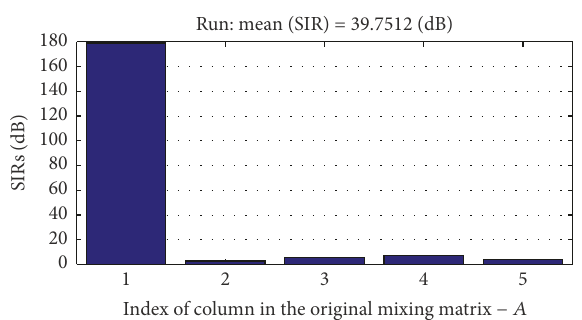
Figure 7: Signal to interference ratio for the mixing matrix.